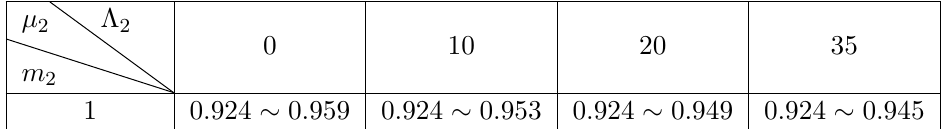
Figure 3 . Left : the mass M of the SIMBSs as a function of the synchronized frequency ω with the azimuthal harmonic indexes m 2 = 1 , 2 , 3 . Right : the mass M of the SIMBSs as a function of the nonsynchronized frequency ω 2 with ω 1 = 0 . 85 . The horizon red dashed line indicates the mass M = 1 . 26 . In both panels, the dashed and solid lines stand for Λ 2 = 0 and Λ 2 = 10 , respectively. The black spiral curve indicates the ground state with m = 1 and all solutions have µ 1 = 1 , µ 2 = 0 . 93 , m 1 = 1 .